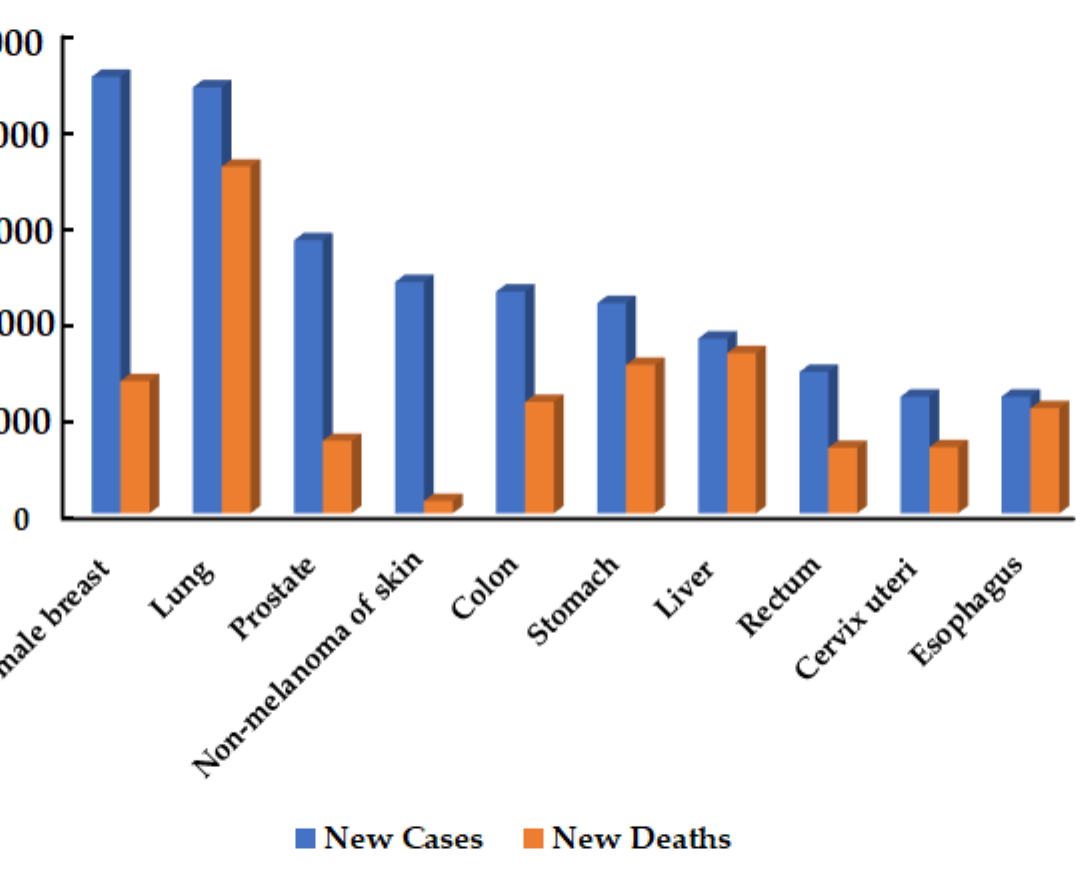
Figure 1. Predominance of different cancer types in 2020 (replotted from data obtained from [37]. Copyright 2022, copyright holder John Wiley and Sons, New Jersey) .